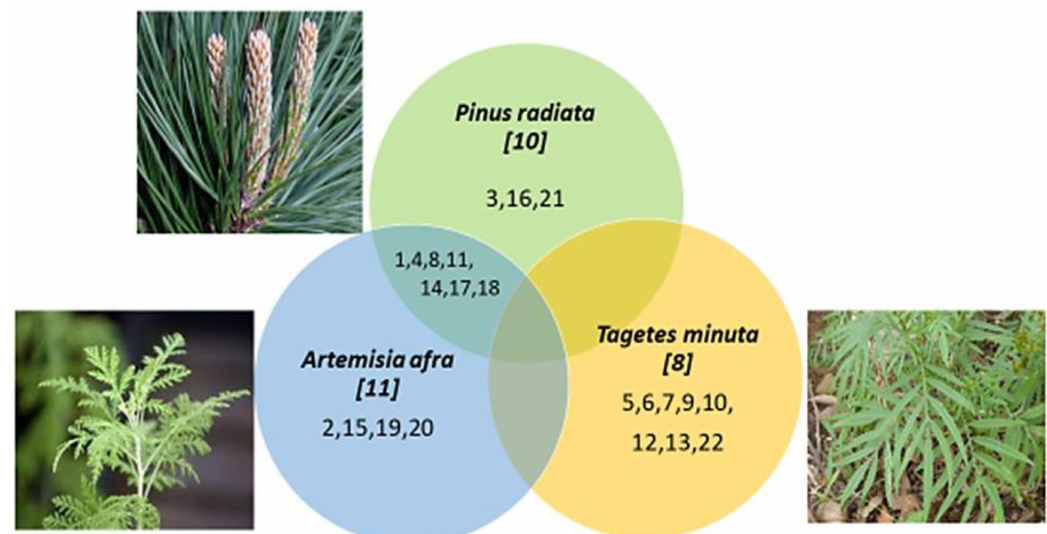
Figure 8. Venn diagram of shared and specific VOCs detected by GC-MS in the VOC fractions as sampled by the BID-SDME method. The number in italics indicates the total number of annotated terpenes/terpenoids. The numbers within the circles correspond to the numbered chemicals as indicated in Table 1. Corresponding structures are provided in Table